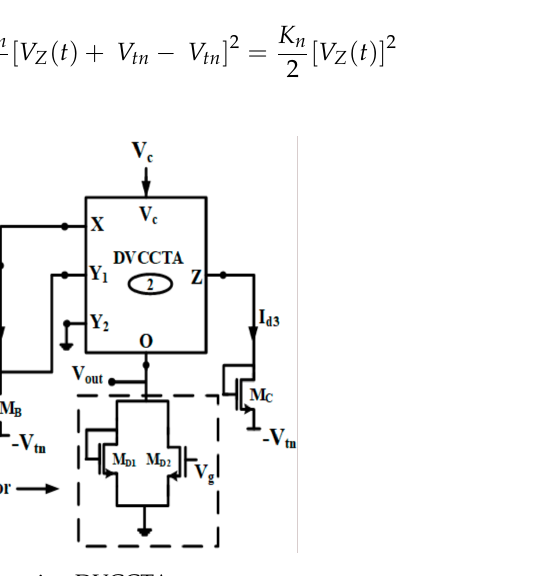
Figure 3. Full-wave rectifier circuit using